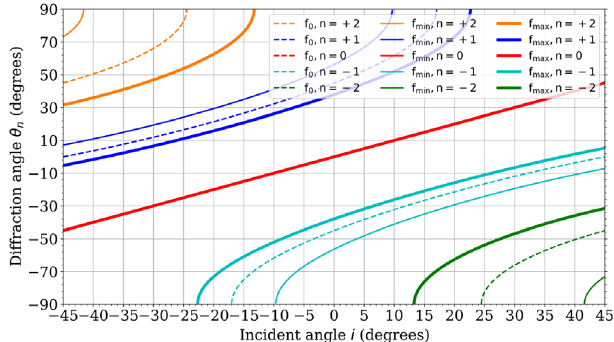
Figure 3. Domains of existence (bounded by full lines) for the different diffracted orders (0, ±1, ±2) as a function of the incident angle and frequency content of the emitted